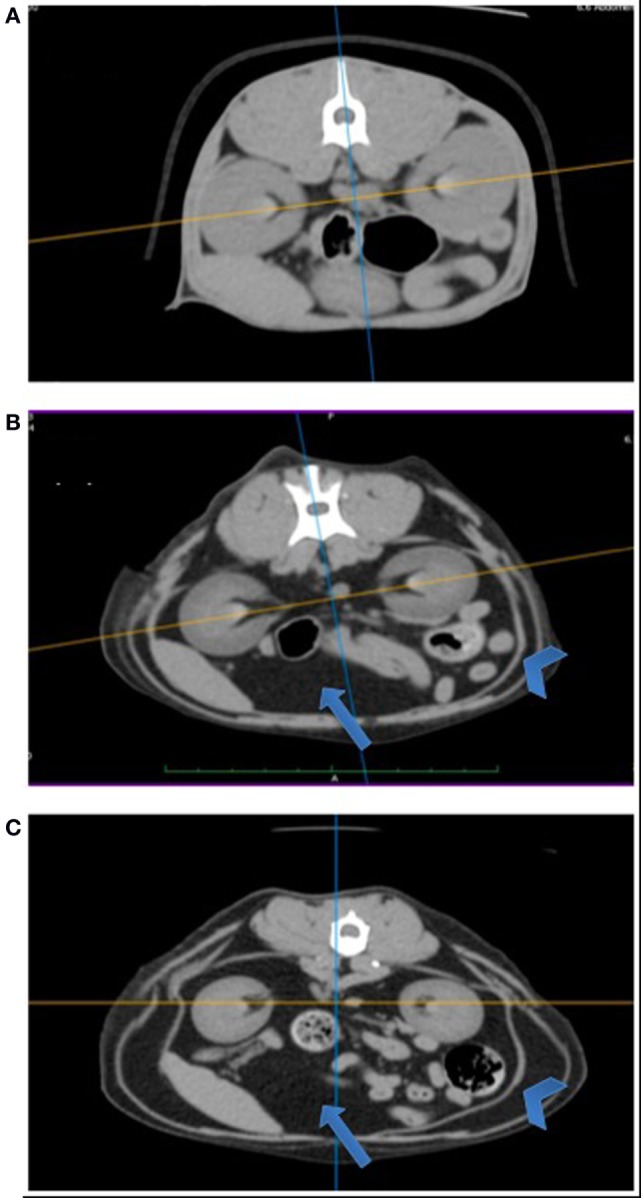
Comparison of cross-sectional abdominal computed tomography (CT) images at the level of renal pelvis among BCS 3, 4, and 5 cats. Cross-sectional abdominal CT images at the level of renal pelvis are presented: (A) BCS 3 cat; (B) BCS 4 cat; and (C) BCS 5 cat. Arrows point to intra-abdominal area (visceral fat), and arrowheads point to subcutaneous area. Note with increasing BCS, visceral fat (appeared as black area, arrow) volume increases, occupying more spaces relative to abdominal organs. Subcutaneous fat depot (arrow head) also increases with increasing BCS.